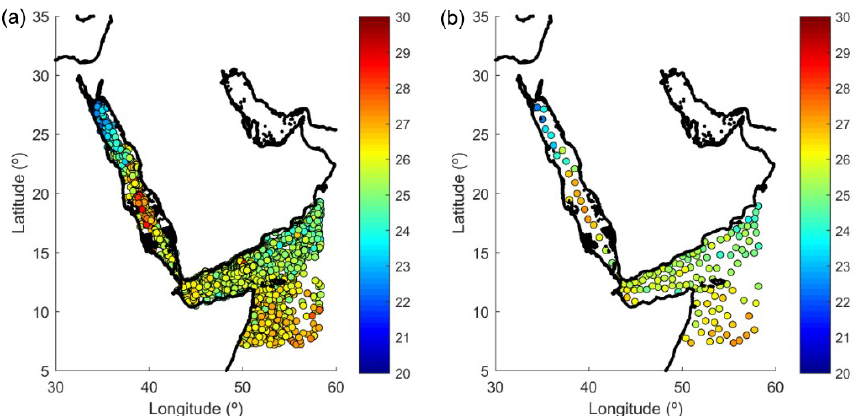
Figure 5. (a) Distribution of all the available observations for January ( n = 2705). (b) Distribution of observations after applying the K-means algorithm ( n = 135).